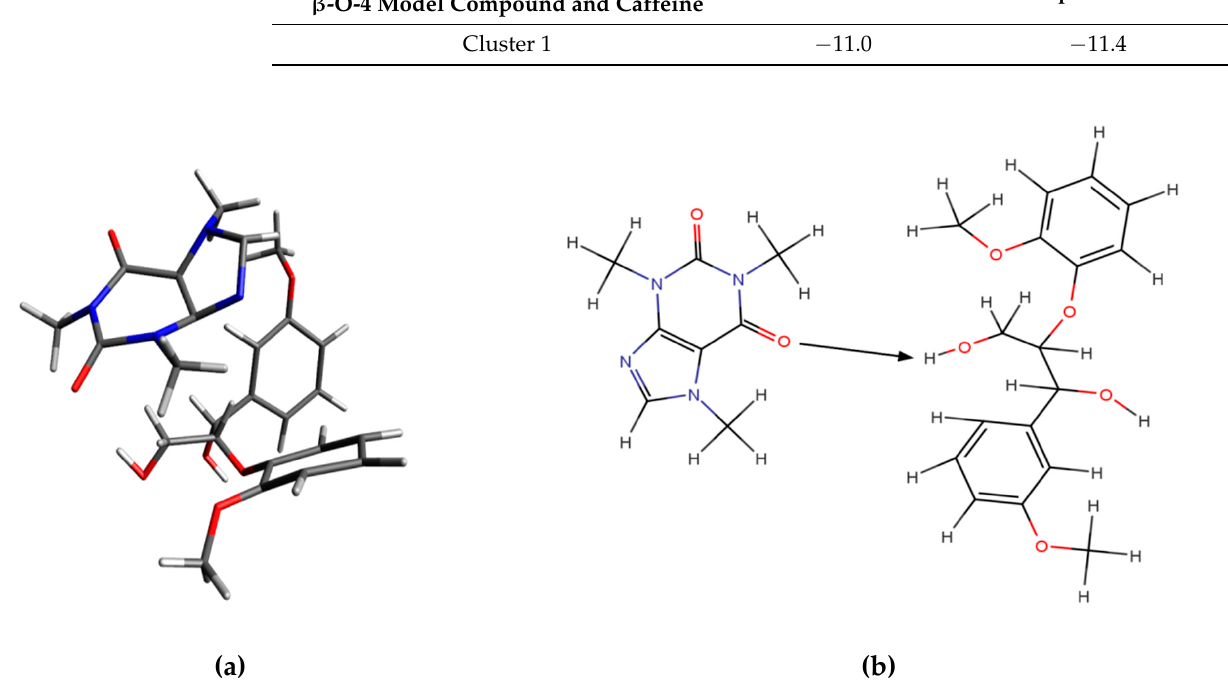
Table 4. Interaction energy between α R, the β R guiacyl β -O-4 model compound, and caffeine in the obtained average cluster structure. System Consisting of α R, the β R Guiacyl β -O-4 Model Compound and Caffeine